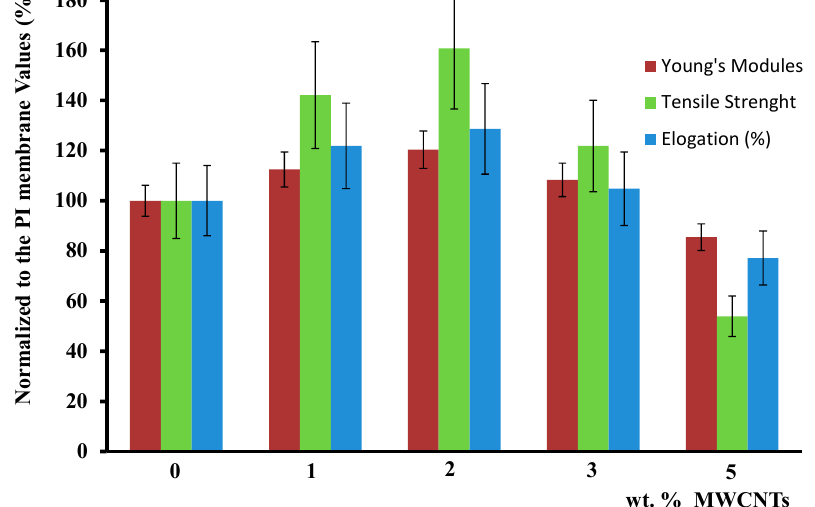
Figure 7. Relative representation of Young’s modulus, elongation, and ultimate tensile strength of tested PI samples as a function of MWCNTs concentration.